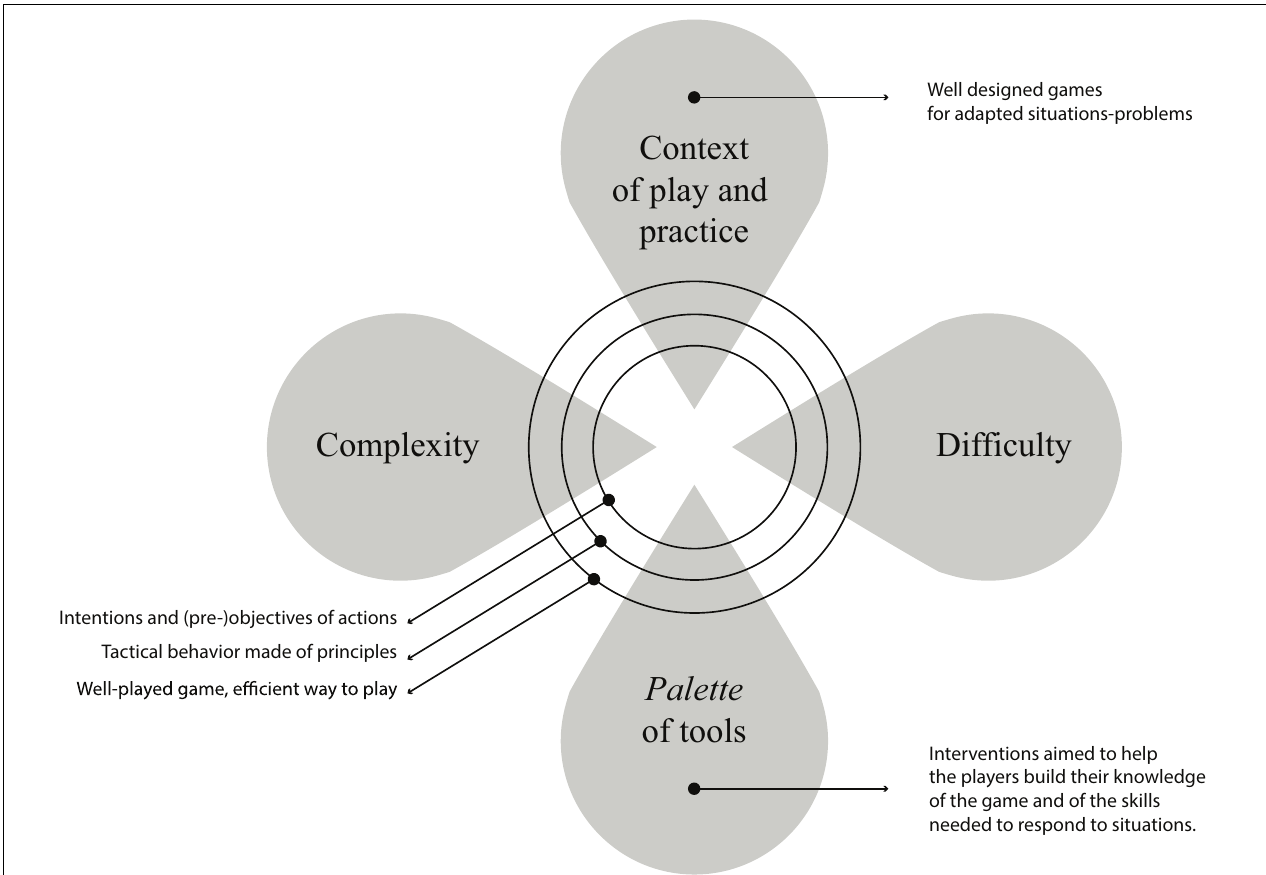
FIGURE 3 | Interpretation of the assembling of the main elements useful to interactionist theories to teach and learn the play (e.g., Constructivist, Ecological and Socio-Cultural